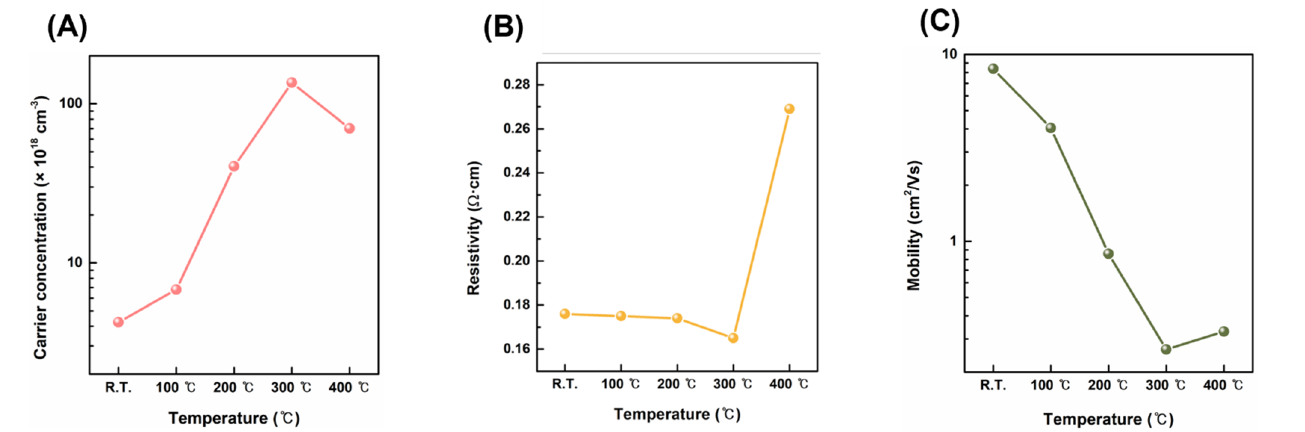
Figure 3. Electrical properties of CuO films with different postannealing temperatures obtained from Hall measurement: ( A ) carrier concentration; ( B ) resistivity; ( C ) mobility.